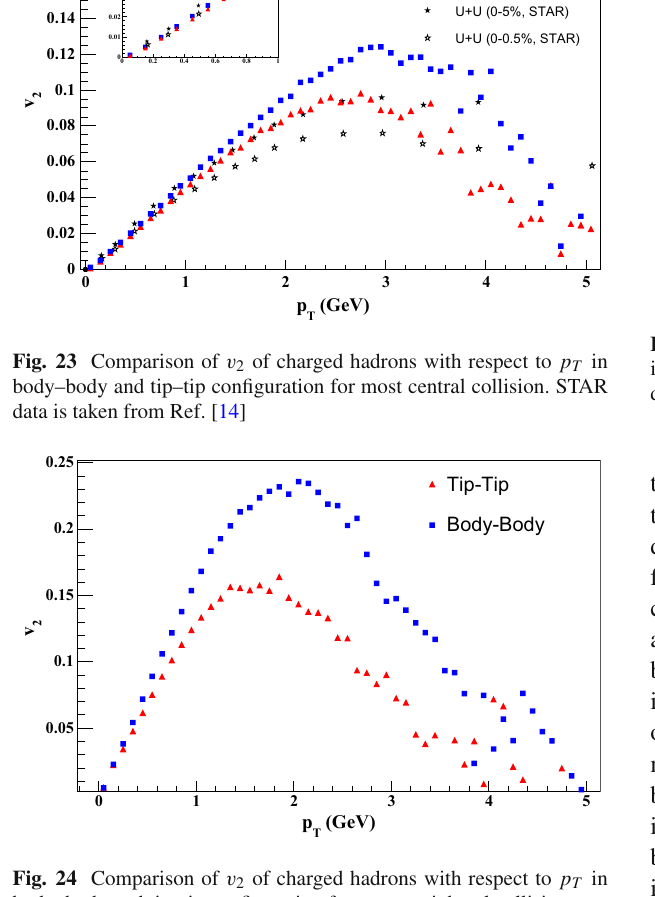
Fig. 24 Comparison of v 2 of charged hadrons with respect to p T in body–body and tip–tip configuration for most peripheral collision